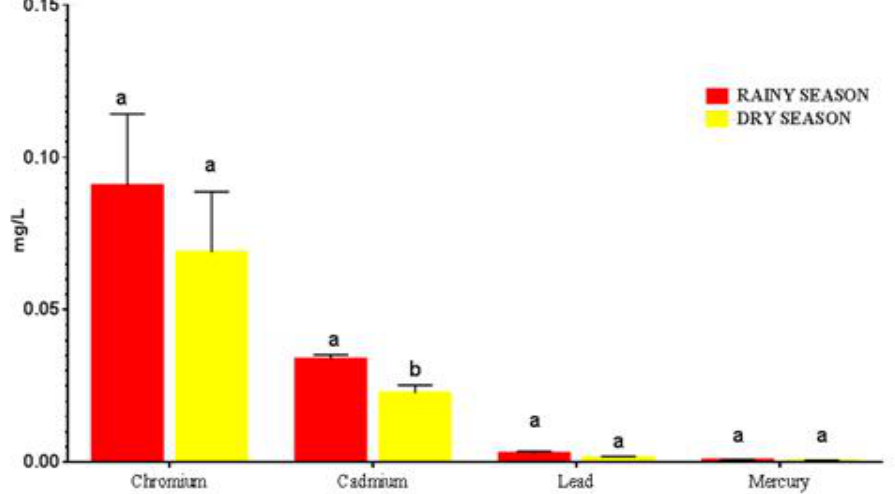
Fig. 5: Comparing heavy metals distribution by season. Data are presented as the mean ± S.E.M. p value < 0.05 . Statistical analyses were performed by two-way ANOVA test, followed by Uncorrected Fisher’s LSD test for multiple comparisons (P 0.482 in Chromium, P = 0.067 in Lead, P = 0.146 in Mercury, P > 0.05; P = 0.001 in Cadmium, P < 0.05). Mean that do cal cal cal not share same alphabet are significantly